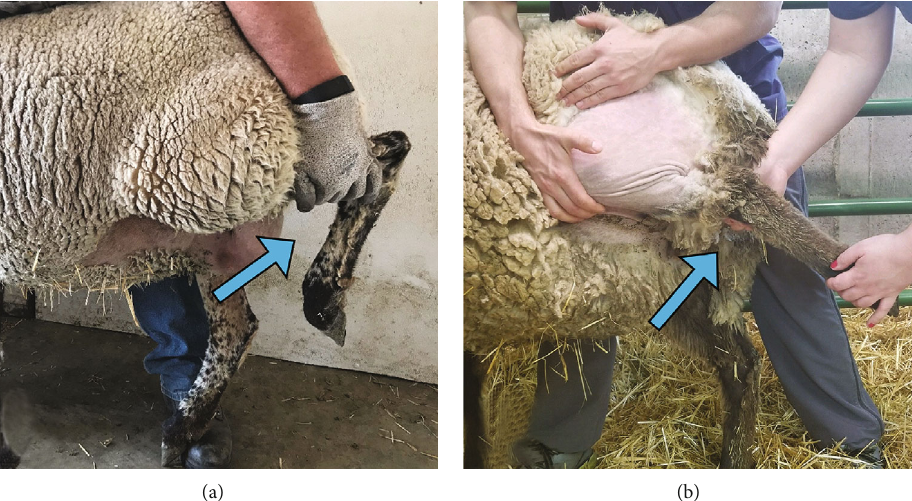
Figure 2: Normal antemortem sti fl e fl exion compared to that of a sheep with an injured peroneus tertius. Damage to the PT in six out of eight sheep that underwent CCLD for use in a gene therapy study was suspected based on clinical signs (b) when compared to healthy una ff ected sheep (a).